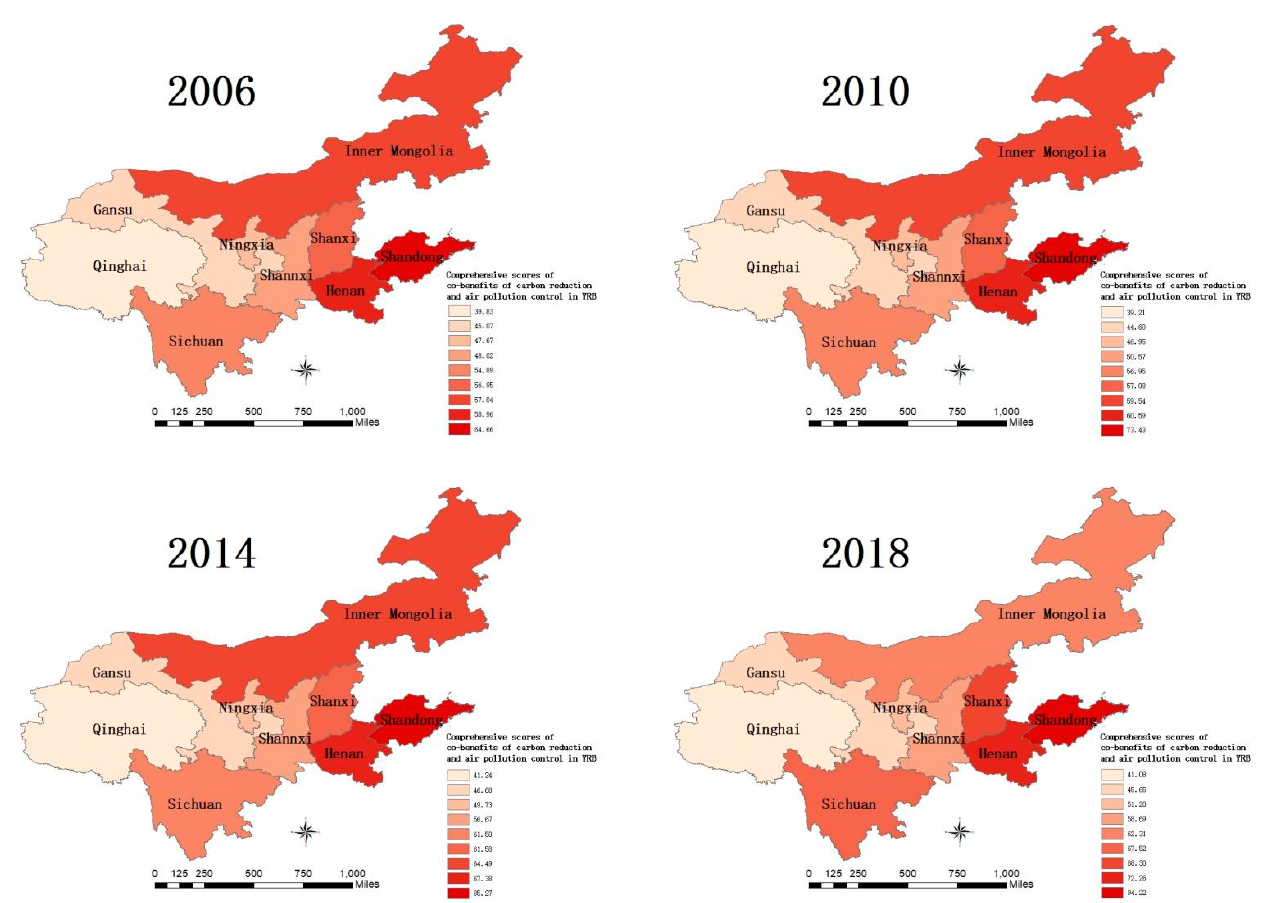
Figure 2. Charts of the co-benefits of carbon reduction and air pollution control in the YRB in 2006, 2010, 2014, and 2018.